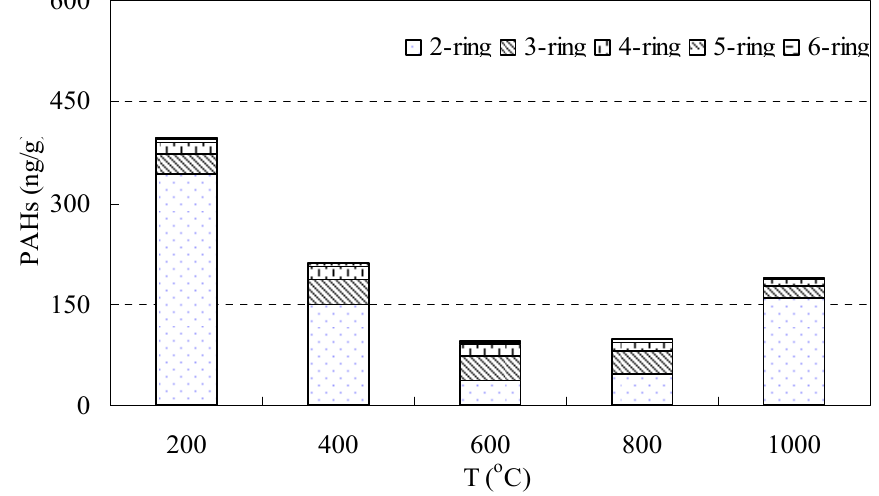
Figure 8. Release of PAHs in the oxygen-enriched burning test at different temperatures, according to ring number.